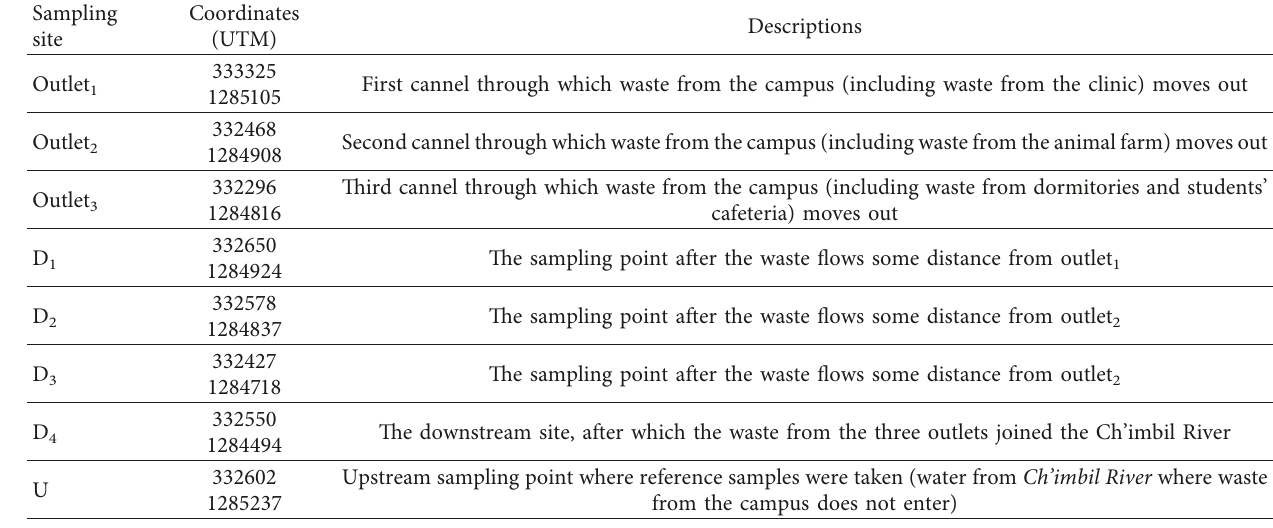
Table 1: Description of the sampling sites.